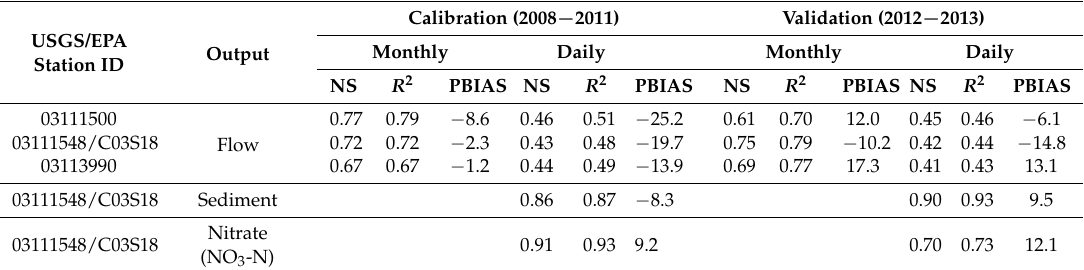
Table 1. Summary of calibration and validation of watershed for flow and nutrients.